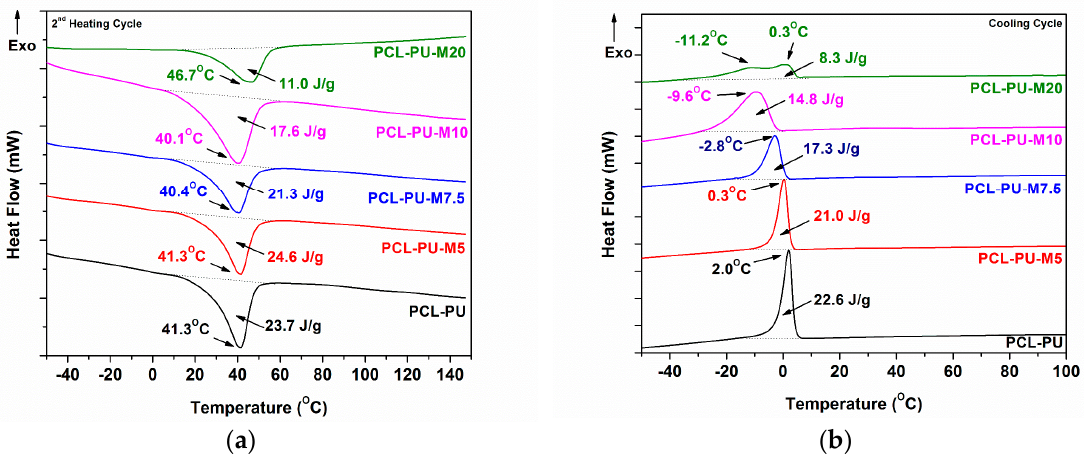
Figure 2. Differential scanning calorimetry (DSC) thermograms: ( a ) Second heating and ( b ) cooling cycle of the PCL-PU and PCL-PU-Chitosan biocomposites.